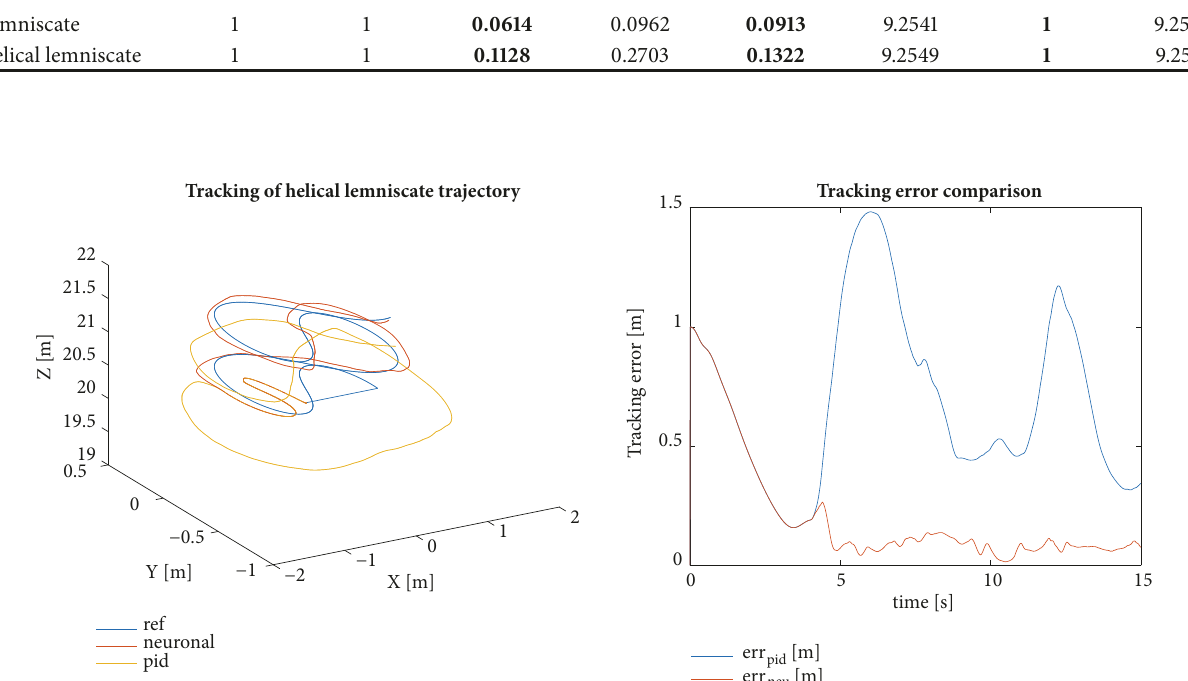
Figure 17: UAV tracking of a helical lemniscate trajectory with wind disturbance (left) and its tracking error